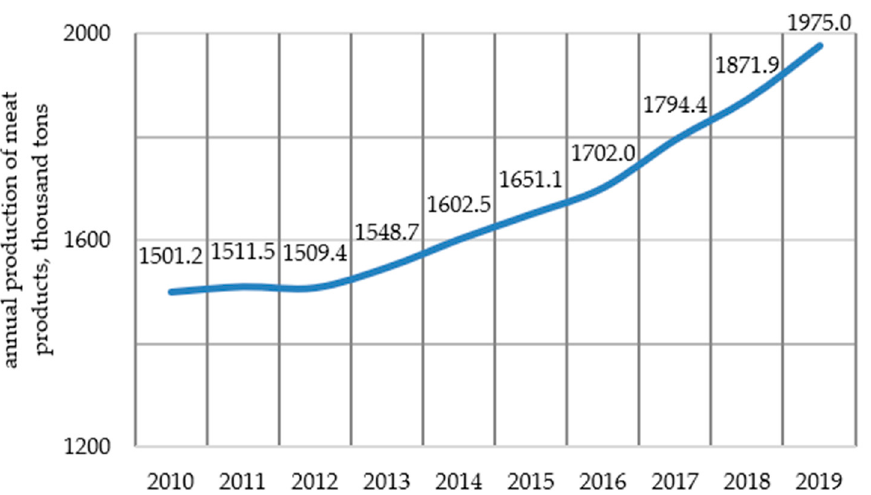
Figure 9. Production of meat products in the Republic of Kazakhstan for 2010–2019. Source: Stat.gov.kz, 2021. Available online: https://stat.gov.kz/ (accessed on 26 May 2021).